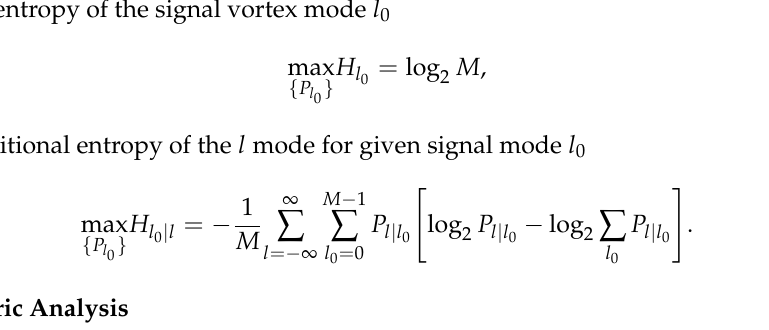
χ for different topological charge of T